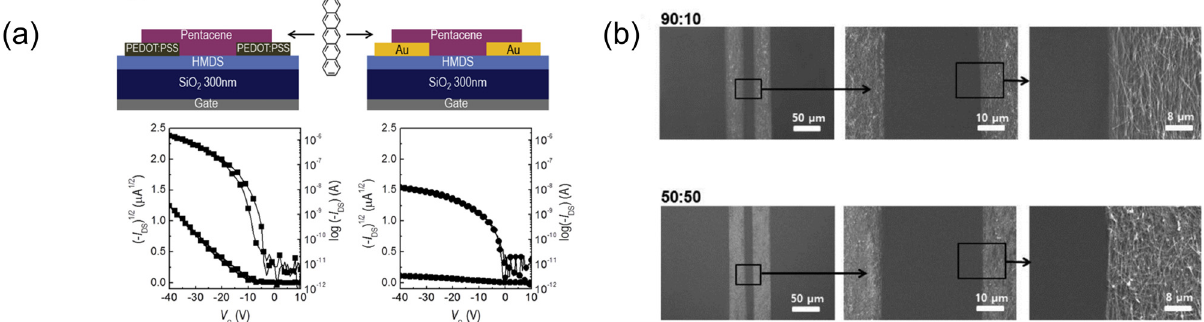
Figure 12: ( a ) Schematic diagram of the structure of organic thin fi lm transistors with m - PEDOT:PSS and Au electrodes and their transfer characteristics and output characteristics. Reproduced from ref. [ 139 ] with permission from Elsevier. ( b ) S/D patterns made of AgNWs/PEO mixed materials with weight ratios of 90:10 and 50:50, respectively. The enlarged form of the interface between the electrode and the channel is shown in the rightmost image. Reproduced from ref. [ 141 ] with permission from